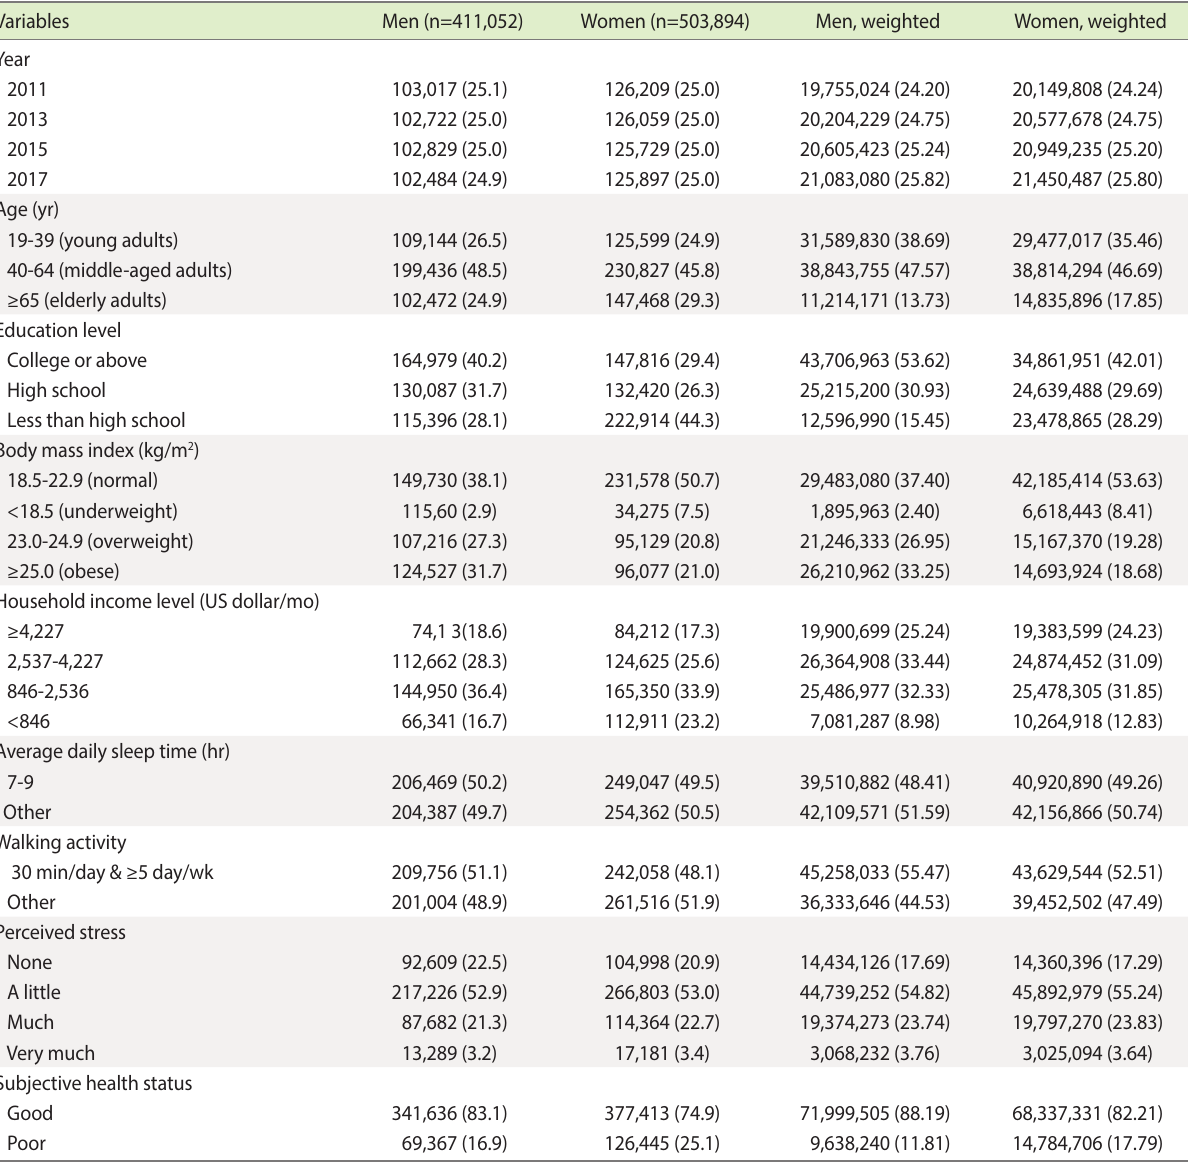
Table 1. Sample size for sedentary behavior in the Korean population by socio-demographic and lifestyle characteristics, using 2011-2017 Korea Community Health Survey